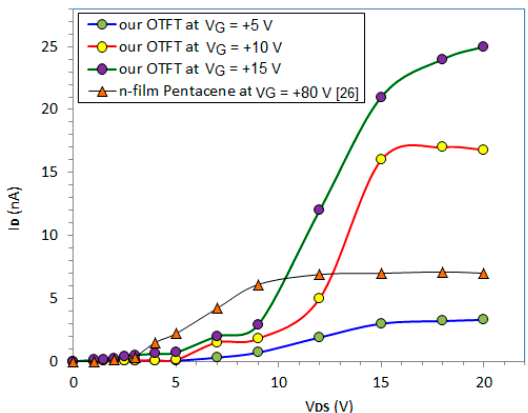
Figure 8. The output characteristics, I D -V DS , of our OTFT and those of an experimental n-type OTFT made from pentacene [26].